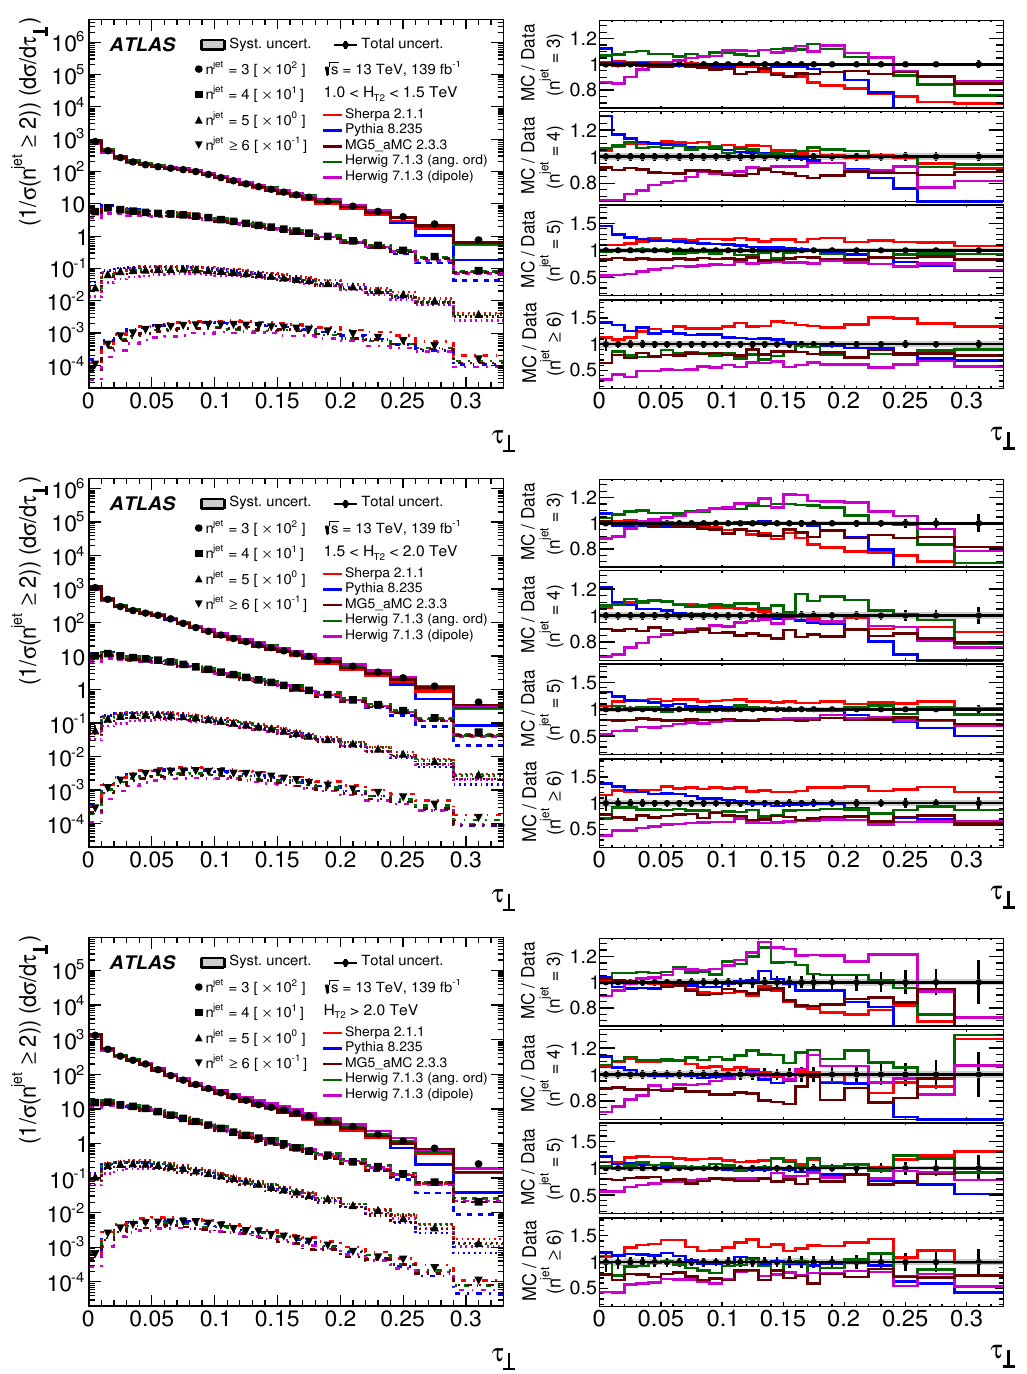
Figure 5 . Comparison between data and MC simulation as a function of the transverse thrust τ ⊥ (see eq. 3.1) for different jet multiplicities and energy scales. For illustration purposes, the corresponding differential cross section for each jet multiplicity is multiplied by 10 2 ( n jet = 3), 10 1 ( n jet = 4), 10 0 ( n jet = 5), 10 − 1 ( n jet ≥ 6). The right panels show the ratios between the MC and the data distributions. The error bars show the total uncertainty (statistical and systematic added in quadrature) and the grey bands in the right panels show the systematic